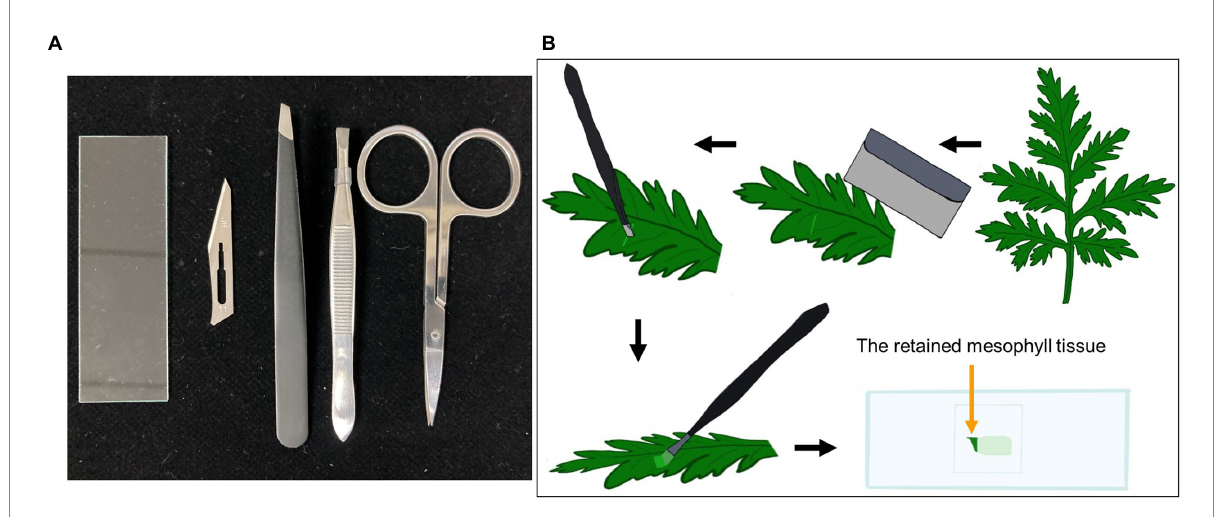
FIGURE 1 (A) Tool kit including precise slanted tweezer, surgical knife blade, scissor, and glass slide for tissue sample preparation; (B) Schematic representation for the process of tearing off epidermis from the odd-pinnately compound leaf of Artemisia annua . The first step in the process was to select healthy fresh leaves. Secondly, gently scratch the leaves with surgical blade. Thirdly, tear off the uniseriate epidermis using slanted tweezer softly, with a little of mesophyll tissue retained. The final step was to spread the epidermis onto PEN slides for the subsequent